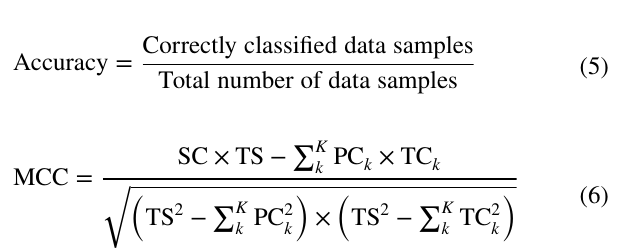
Fig. 10 Comparison among diverse learning strategies for MLP clas- sifier for prediction of lithofacies